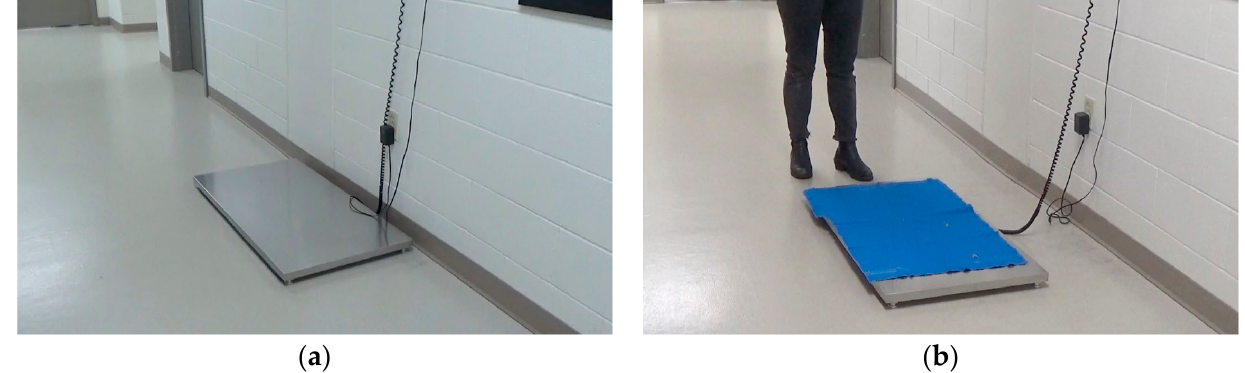
Figure 1. ( a ) Scale set up for control group and ( b ) intervention group. The scale procedure for the control group occurred at the beginning of the appointment; for the intervention group, it occurred at the end of the appointment.